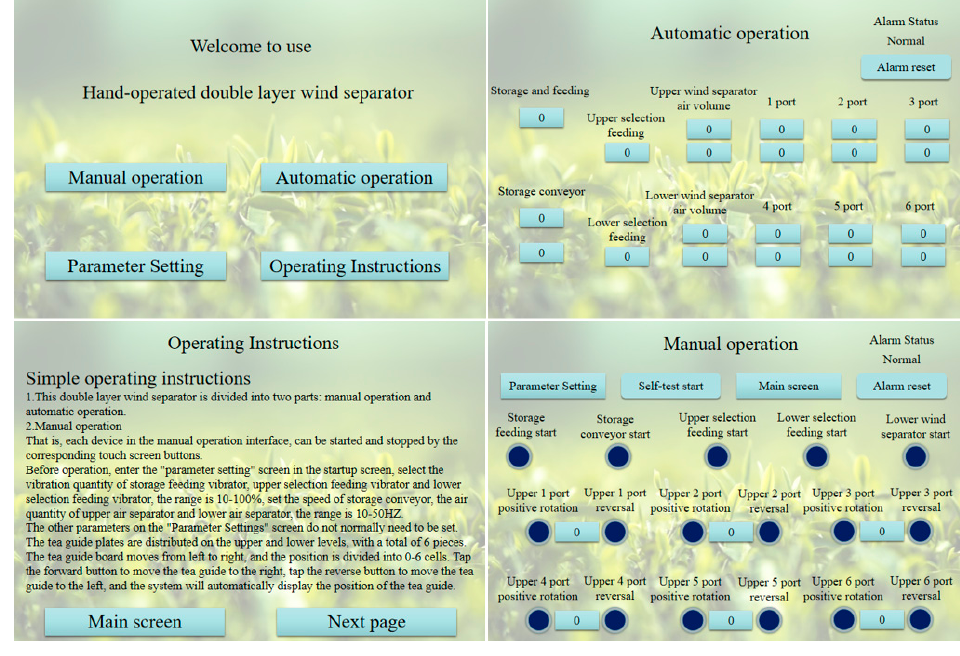
Figure 11. Configuration interface.